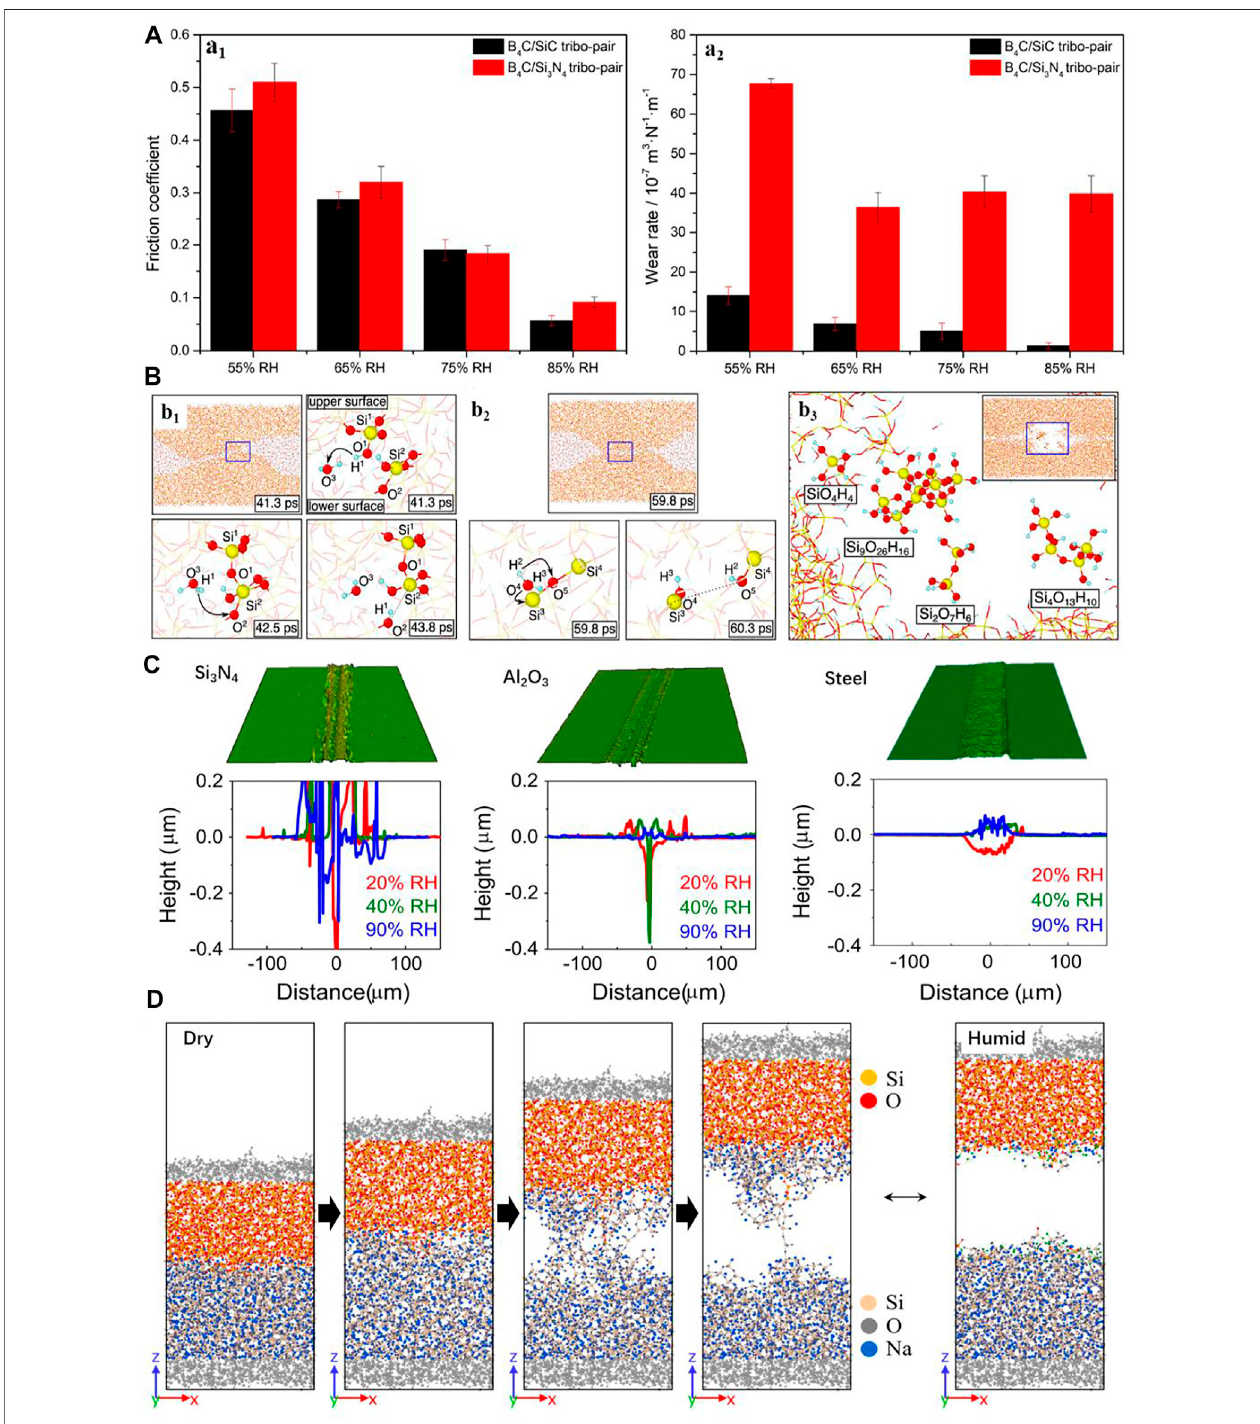
FIGURE 4 | (A) Friction coef fi cients (a 1 ) and wear rates (a 2 ) ofSiC and Si 3 N 4 against B 4 C balls under various RH conditions. Adapted from Cao et al., 2020 (B) MD simulations of the self-mated sliding of SiC in water environment. (b 1 ) Interfacial Si – O – Si bonds formed resulting in Si atom removal. (b 2 ) Water molecule dissociating the interfacial Si – O – Si bonds. (b 3 ) Formation of colloidal silica and hydrophilic hydrate particles. Adapted from Ootani et al., 2020b (C) Optical images and corresponding cross-sectionpro fi lesoftheweartracksontheSLSglasssurfacesagainstSi 3 N 4 ,Al 2 O 3 ,andstainlesssteelballsastheRHrangesfrom20%to90%.Adaptedfrom He et al., 2015 (D) MD simulations showing the interfacial bonds between amorphous silica counter-surface and sodium silicate glass substrate formed under dry conditions and without the interfacial bond forming in water. Adapted from Hahn et al., 2020.